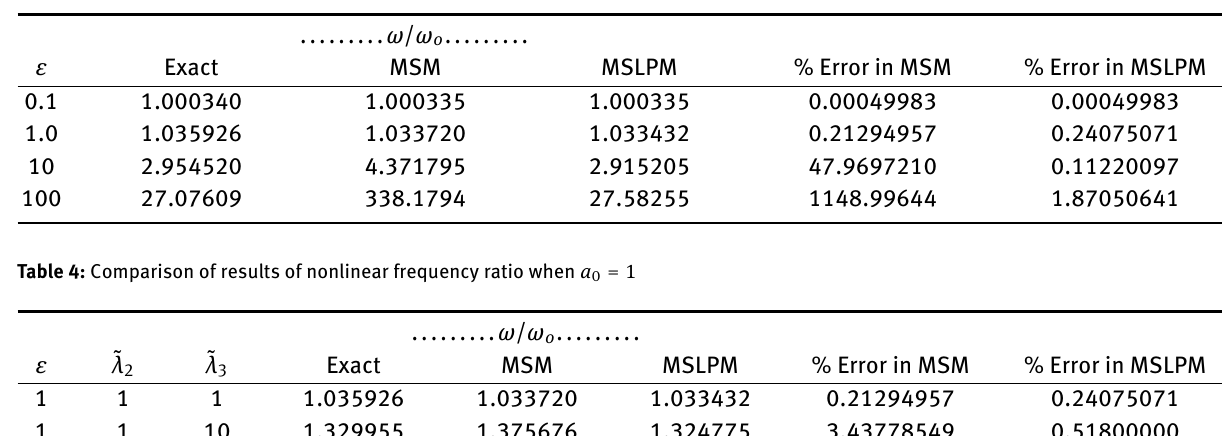
Table 3: Comparison of results of nonlinear frequency ratio when a 0 = ˜ λ 2 = ˜ λ 3 = 1